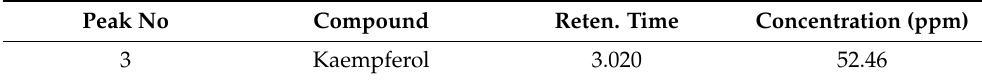
Table 3. Identification of kaempferol in T. aphylla by isocratic HPLC. Peak No Compound Reten. Time Concentration